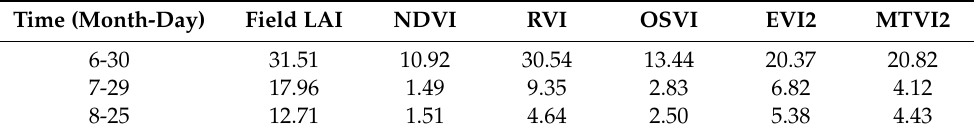
Table 2. CV values of the vegetation indices for the experimental field (%).